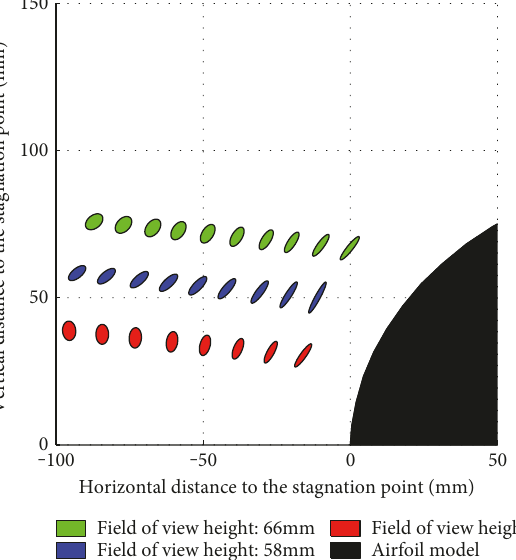
Figure 7: Sketch of the type of results to be expected relative to the airfoil.